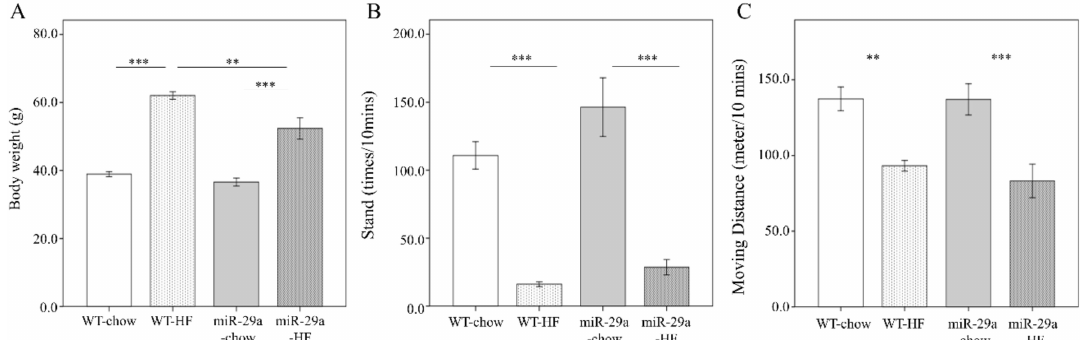
Figure 1. Overexpression of miR-29a reduces weight gain, but has no e ff ect on physical activity in the context of chronic high fat diet (HFD). Weight gain and physical activity of wild type and miR-29aTg mice fed a chow or high-fat diet for 12 months were measured, including ( A ) body weight, ( B ) frequency rearing stand, and ( C ) moving distance documented using a 30 × 30 cm open field box in ten minutes. Data calculated from five to ten mice per group are expressed as mean ± SE. ** p < 0.01 and *** p < 0.001 between the indicated groups. WT, wild type mice. HFD, high-fat diet. miR-29a, mice harboring overexpression of